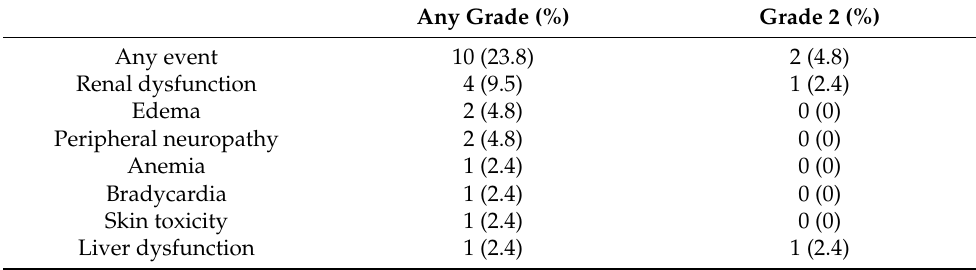
Table 3. Adverse Table 3. Adverse events.